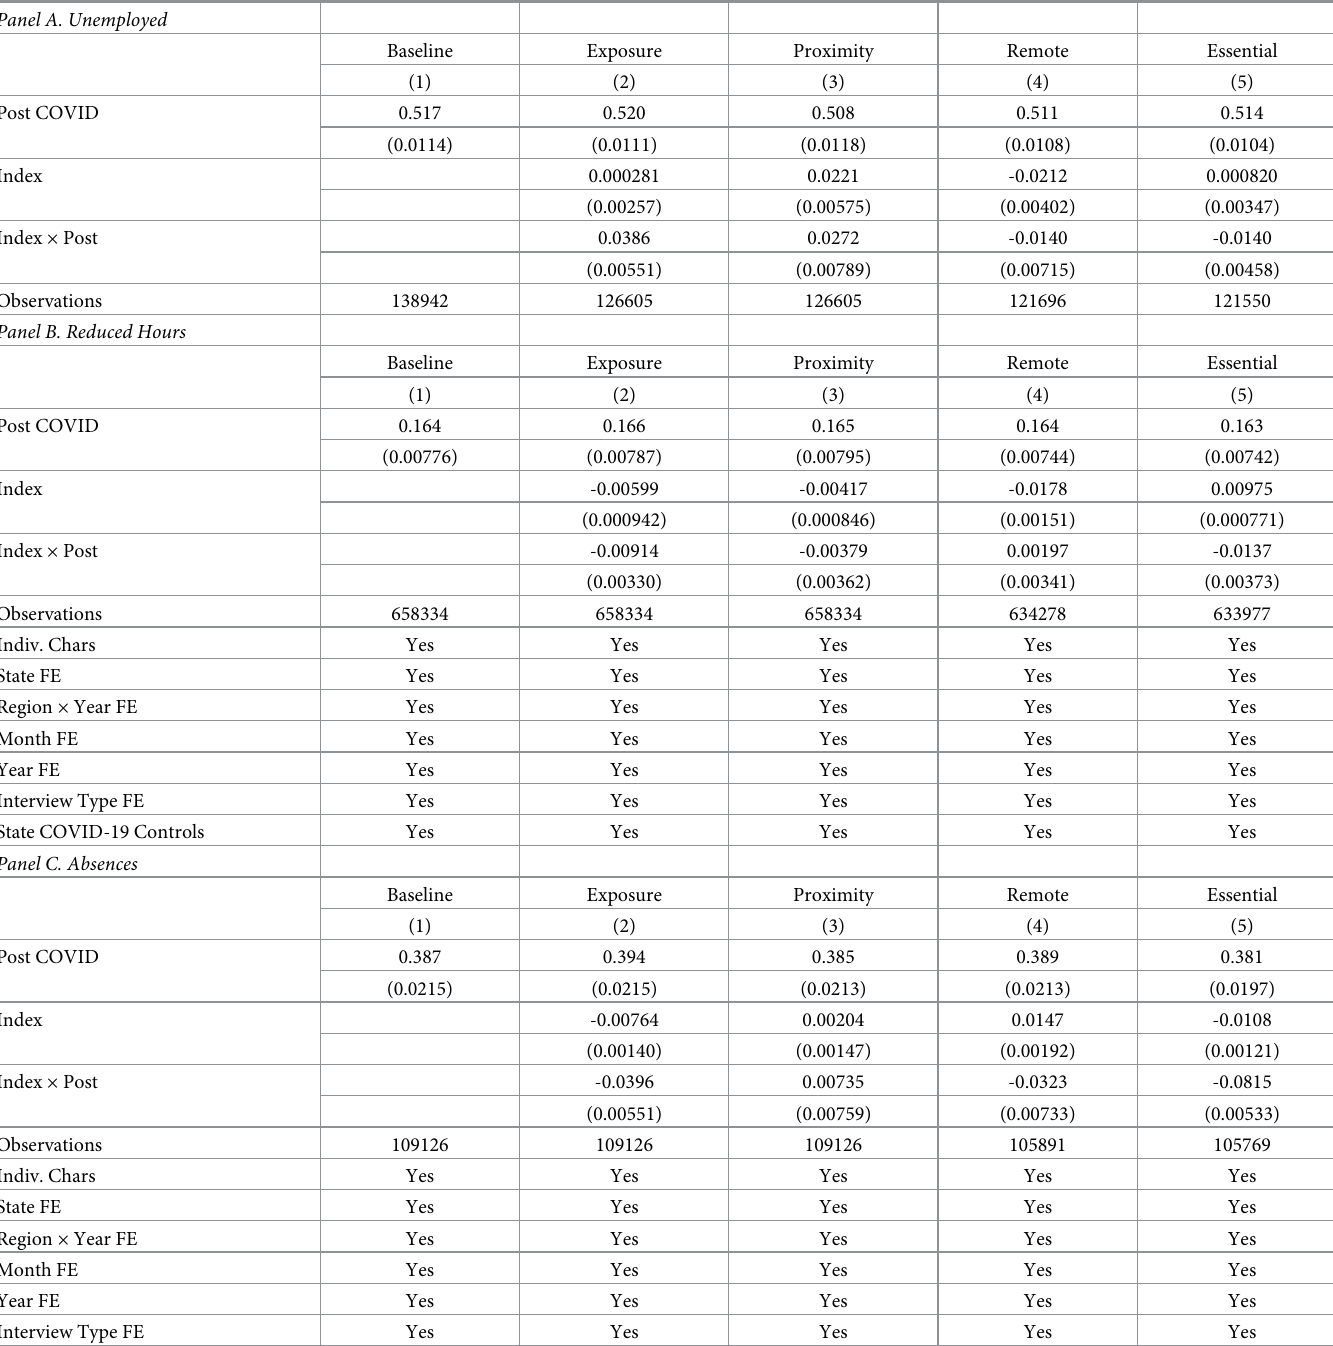
Table 8. COVID-19-related absences, layoffs and involuntary part-time: Exposure, proximity, remote and essential work. Panel A.